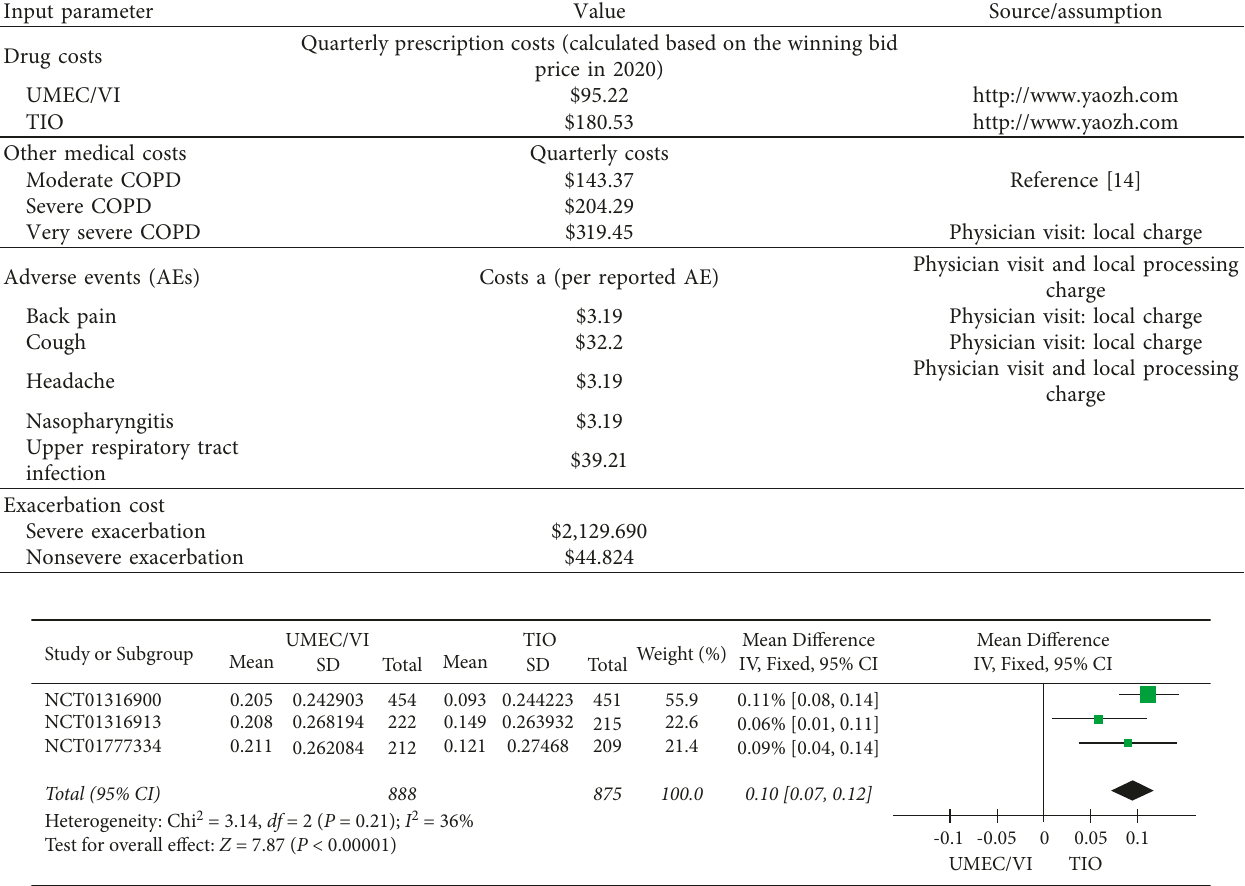
Figure 2: Forest plot of trough FEV 1 for UMEC/VI vs. TIO using random-effects meta-analysis.